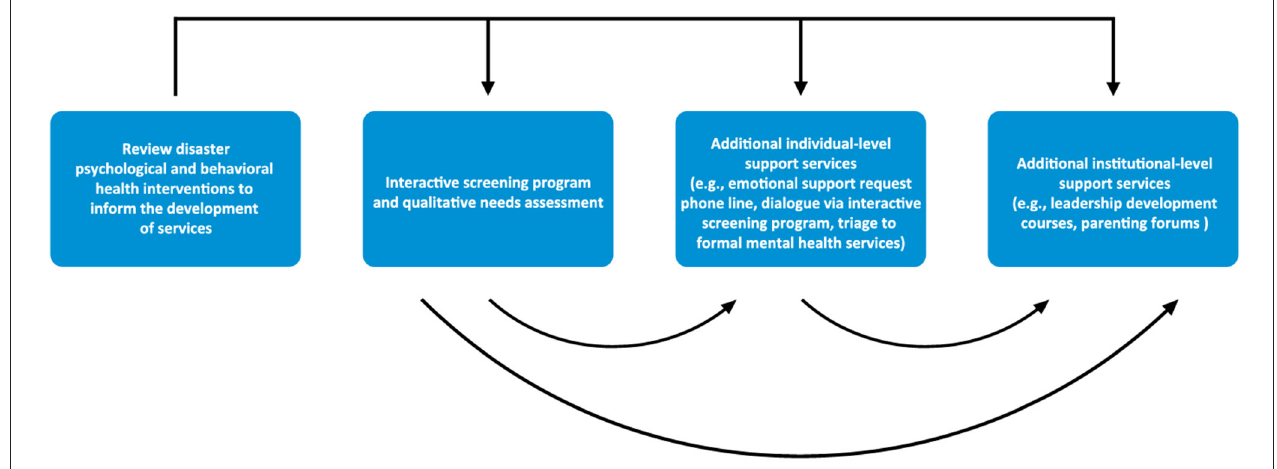
FIGURE 1 | Our institution’s process of developing and introducing emotional support services for HCWs during the COVID-19